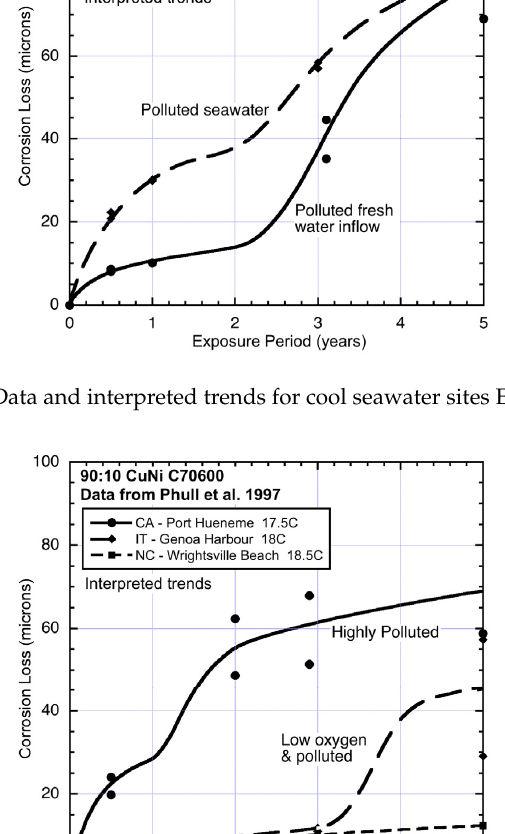
Figure 5. Data and interpreted trends for temperate seawater temperature sites CA, IT and NC. Material 2015 , 8 , page–page